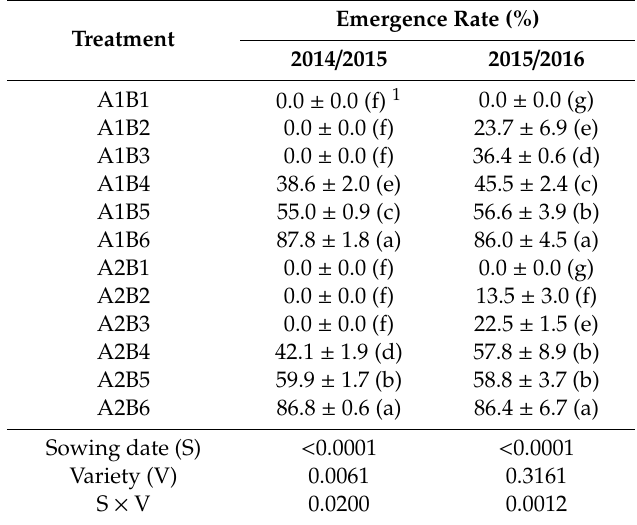
Table 5. Spring emergence rates of wheat with di ff erent sowing